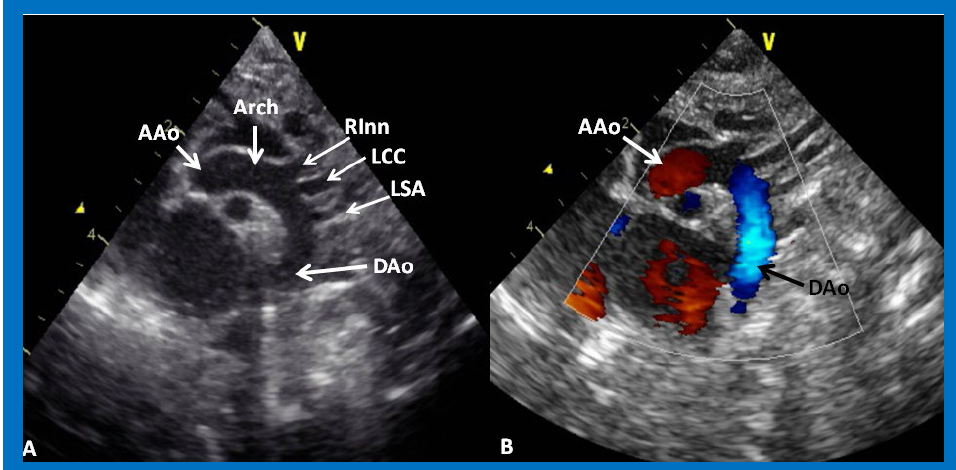
Figure 31. ( A ) Suprasternal notch view of a normal aortic arch (Arch) demonstrating the ascending aorta (AAo), aortic arch (Arch) and descending aorta (DAo). Note the origin of the right innominate (RInn), left common carotid (LCC) and left subclavian (LSA) arteries, arising from the aortic arch. ( B ) The same view with color Doppler imaging, showing red flow in the AAo and blue flow in the DAo. Reproduced from Reference [53].